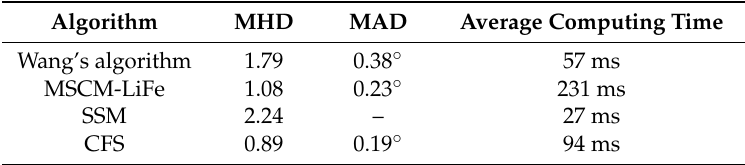
Table 1. Horizon line detection results using the current test